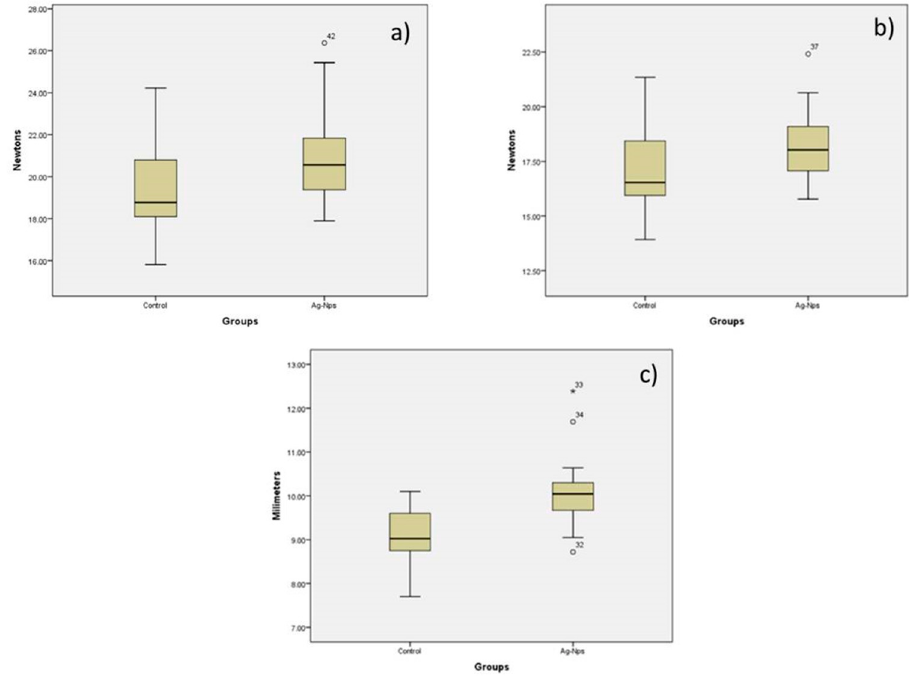
Figure 6. Comparison of orthodontic elastic modules control and orthodontic elastic modules decorated with Ag-NPs for ( a ) Maximum strength; ( b ) Tension; ( c ) Displacement.